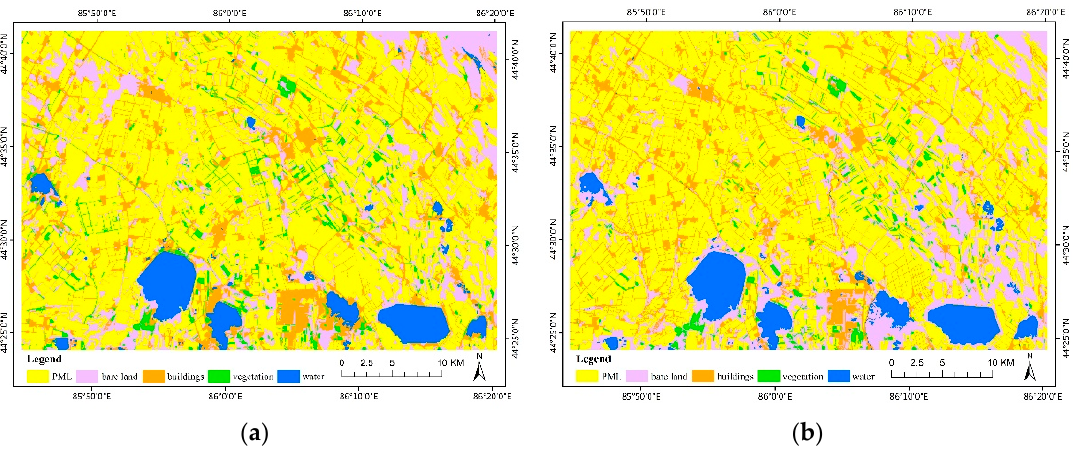
Figure 8. Comparison between the best object-based Plastic-Mulched Landcover (PML) classifications using Sentinel-1 and Sentinel-2: ( a ) object-based Sentinel-1 classification with RF classifier ( b ) object-based Sentinel-2 classification with the SVM classifier.